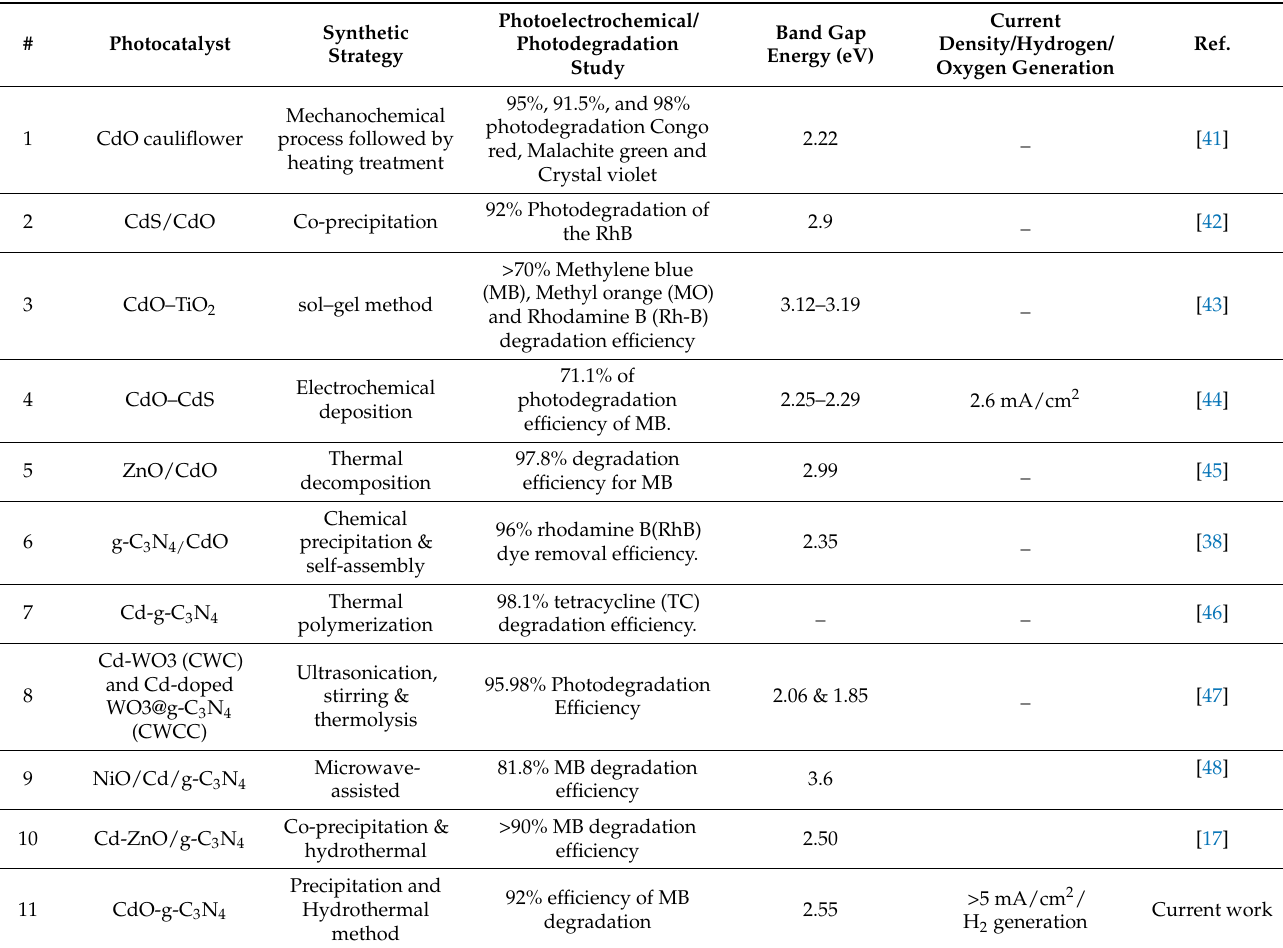
Table 1. A comparison of various recent Cd/CdO nanomaterials or their composites with g-C 3 N 4 and others for Photoelectrochemical/Photodegradation